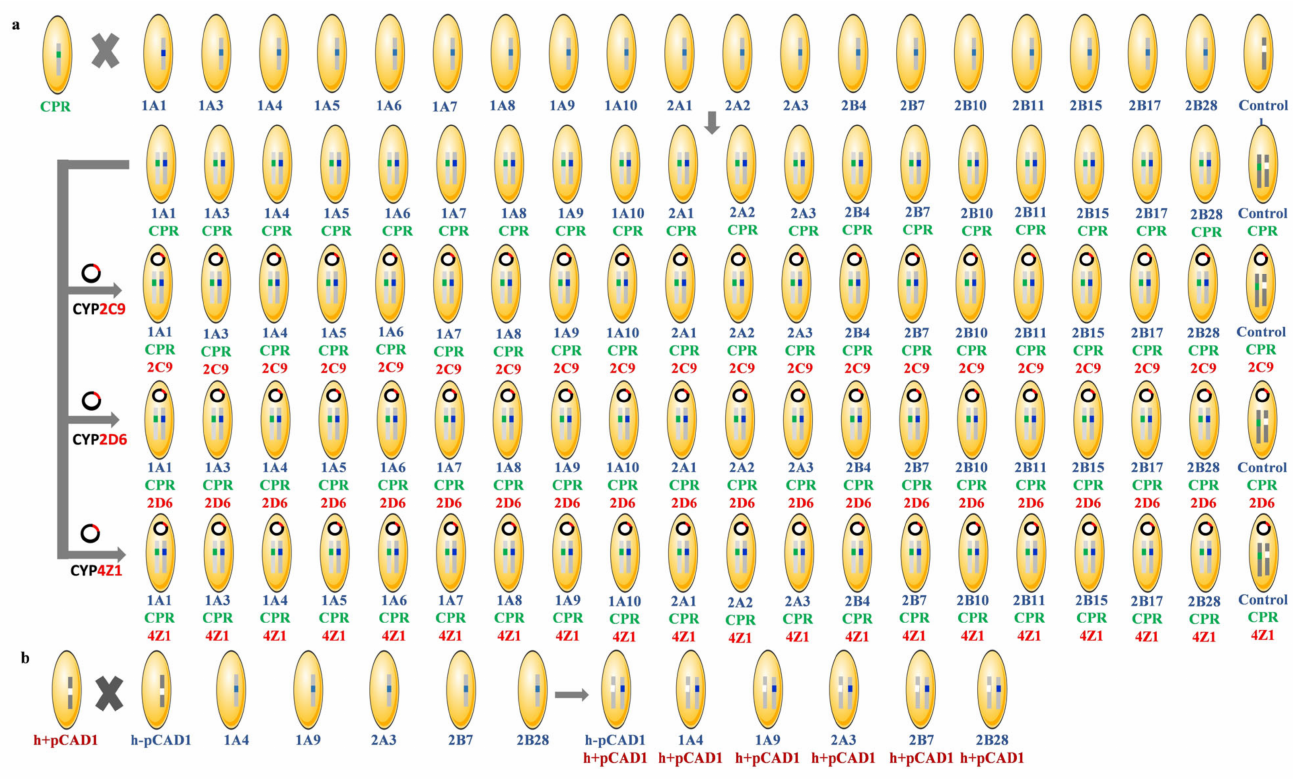
Figure 1. Cloning Strategy. ( a ) Parental haploid strain JMN12 (mating type h-) was transformed with the integrative vector pCAD1 and with 19 derivatives of pCAD1 that contain one of the human UGT genes to yield 20 new strains (SAN3 to SAN22; top, marked blue). Parental haploid strain JMN11 (mating type h+) was transformed with pCAD1-CPR to yield the new strain SAN2 (top, marked green). Mating of these strains yielded 19 new diploid strains that co-express CPR, with one of the UGTs plus a control that only expresses CPR (SAN100 to SAN119; top right). These 20 new diploid strains were then individually transformed with three different autosomal replicating plasmids (pREP1-CYP2C9, pREP1-CYP2D6, and pREP1-CYP4Z1, respectively; marked red) to yield three new series of diploid strains that co-express CPR together with a CYP and a UGT (including controls); these strains are SAN200 to SAN219 (CYP2C9 series), SAN300 to SAN319 (CYP2D6 series), and SAN500 to SAN519 (CYP4Z1 series), respectively. ( b ) Parental haploid strain JMN11 was transformed with pCAD1 yielding SAN1. Mating of this strain with SAN3, SAN6, SAN11, SAN15, SAN17, and SAN22 yielded the new strains SAN120 (no insert), SAN123 (UGT1A4), SAN128 (UGT1A9), SAN132 (UGT2A3), SAN134 (UGT2B7), and SAN139 (UGT2B28) used as diploid controls for UGT activity